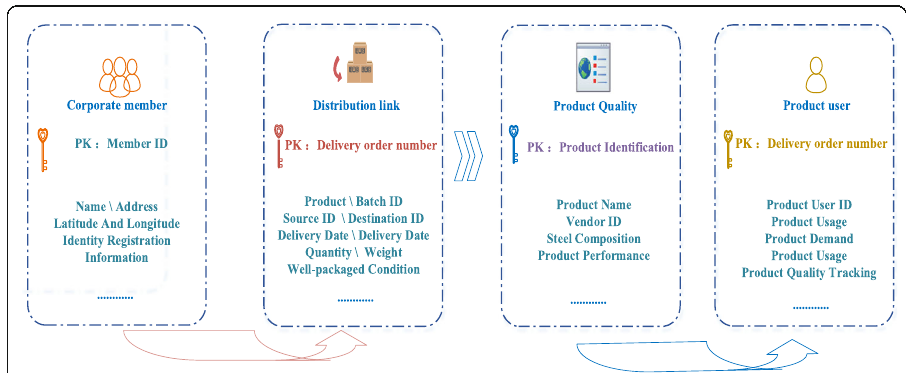
Fig. 4 Partial data structure relationship of personal credit